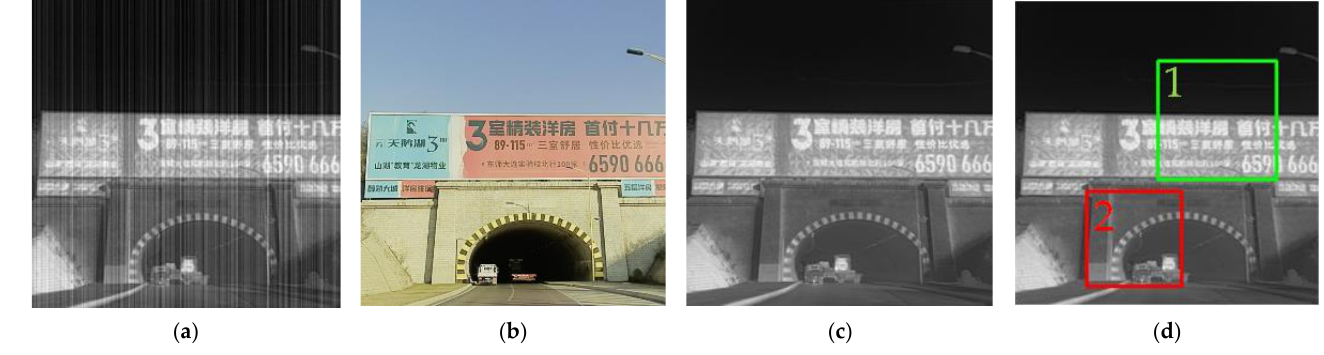
Figure 17. Test data display. ( a ) Input infrared image to be corrected; ( b ) the corresponding visible image; ( c ) ideal output infrared image; ( d ) windows selection.